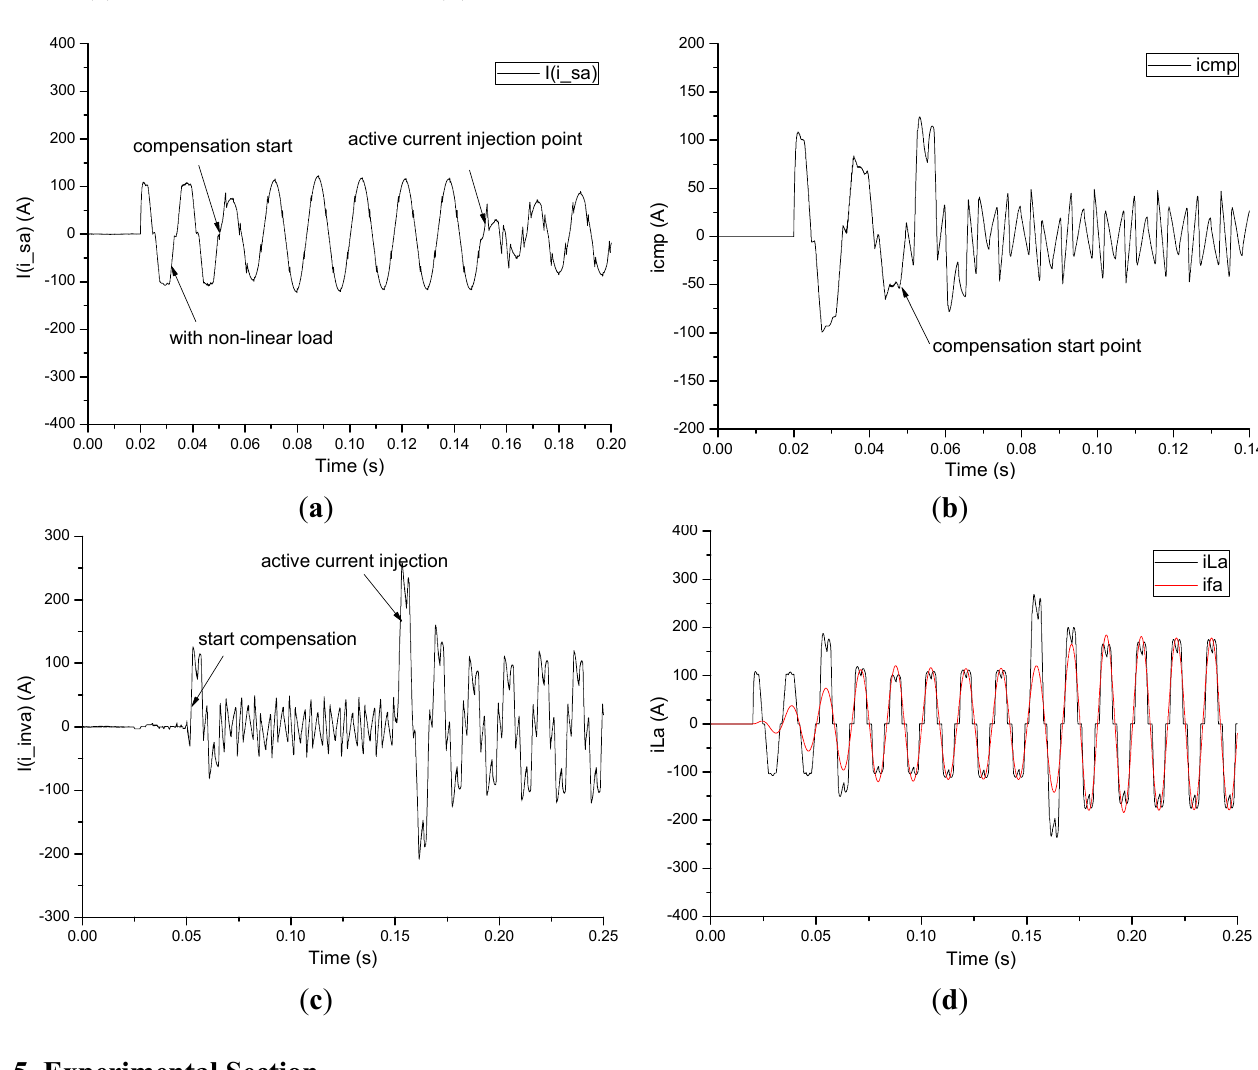
Figure 9. Time response of the ( a ) grid-side current; ( b ) compensation current; ( c ) inverter-side current; and ( d ) load